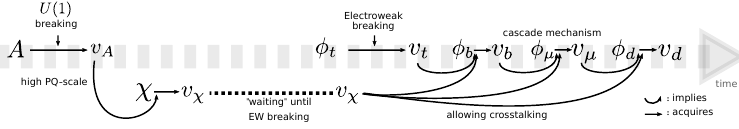
Figure 1 . Schematic view of the development of the radial (cid:12)eld components of the model. At high scales, the new global U(1) PQ symmetry spontaneously breaks. The radial component (solid line) of A then acquires a VEV while the phase becomes a massless Goldstone boson (GB), i.e. the axion (not shown here). The radial component, however, induces a VEV for the radial component of (cid:31) . Until EW symmetry breaking this has no impact whatsoever, but as soon as the radial component of (cid:30) t acquires a VEV by spontaneous EW symmetry breaking, a cascade is triggered. Together, v (cid:31) and v t imply a VEV for v b and so on. Due to the scalar terms, explicitly breaking U(1) 6 U(1) Y U(1) PQ , there are only two massless GBs at the end of the chain, instead of six, ! (cid:2) which are a mixture of the CP-odd components of all the scalar